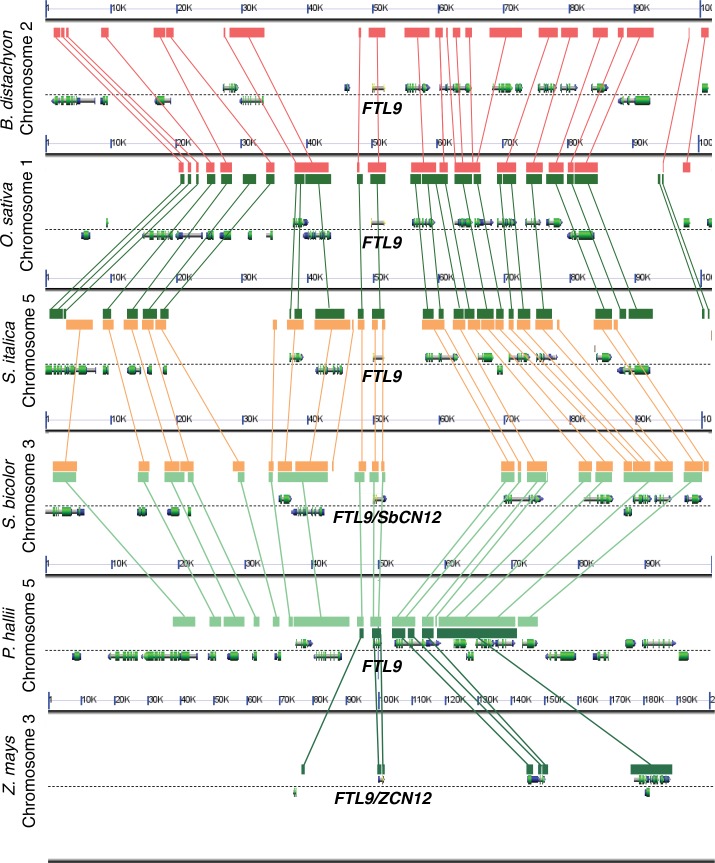
Analysis of syntenic chromosomal regions containing FTL9 orthologs in grasses.Comparative analyses reveal conservation of gene order in an ~100 kb genomic region around FTL9 which supports the designations of FTL9 orthologs throughout the grass family in the FT-like phylogenetic analysis in Figure 2—figure supplement 4 (Lyons and Freeling, 2008).